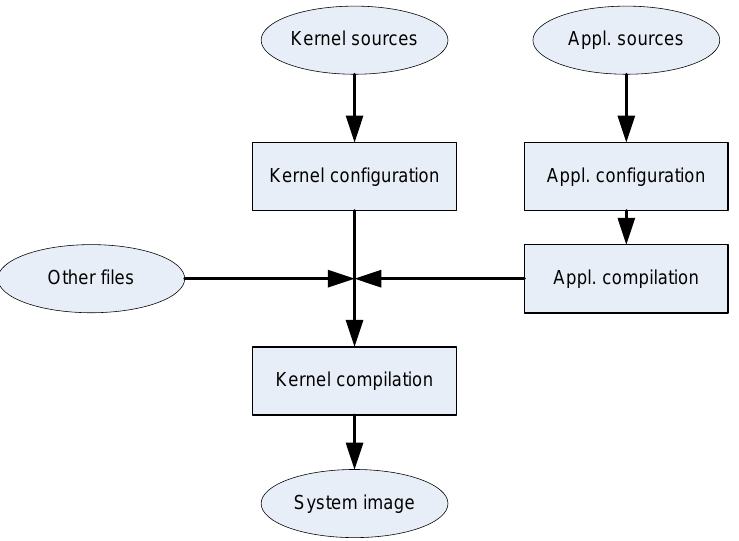
Figure 7. Obtaining the system